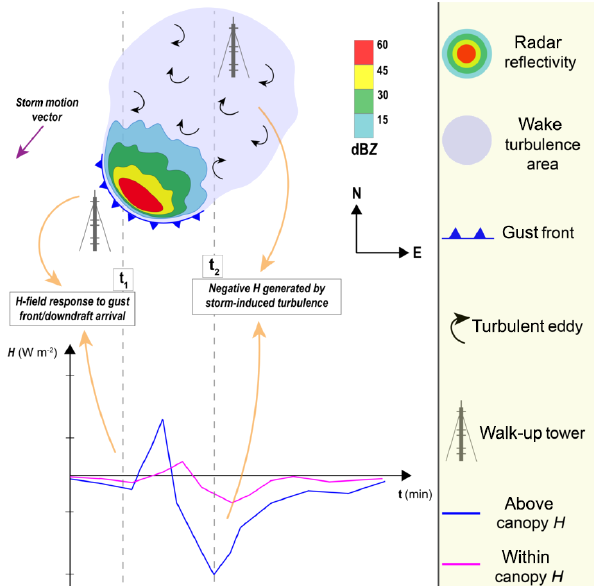
Figure 8. Schematics illustrating the effects of a gust front passage over a tall tower in the forest during nighttime hours. Top: a gust front (blue line with triangles) from a convective storm (cold (warm) colors represent low (high]) radar reflectivity values) approaches the tall tower (gray tower symbol) at t1. At t2, the gust front has passed by the tower site which now is embedded in the turbulent wake of the cold pool (light purple shaded area, with turbulent eddies repre- sented by curly, black arrows). Bottom: corresponding sensible heat flux response to gust front passage at tower levels above (blue) and within (pink) the canopy. The dark purple arrow indicates the storm motion vector (due